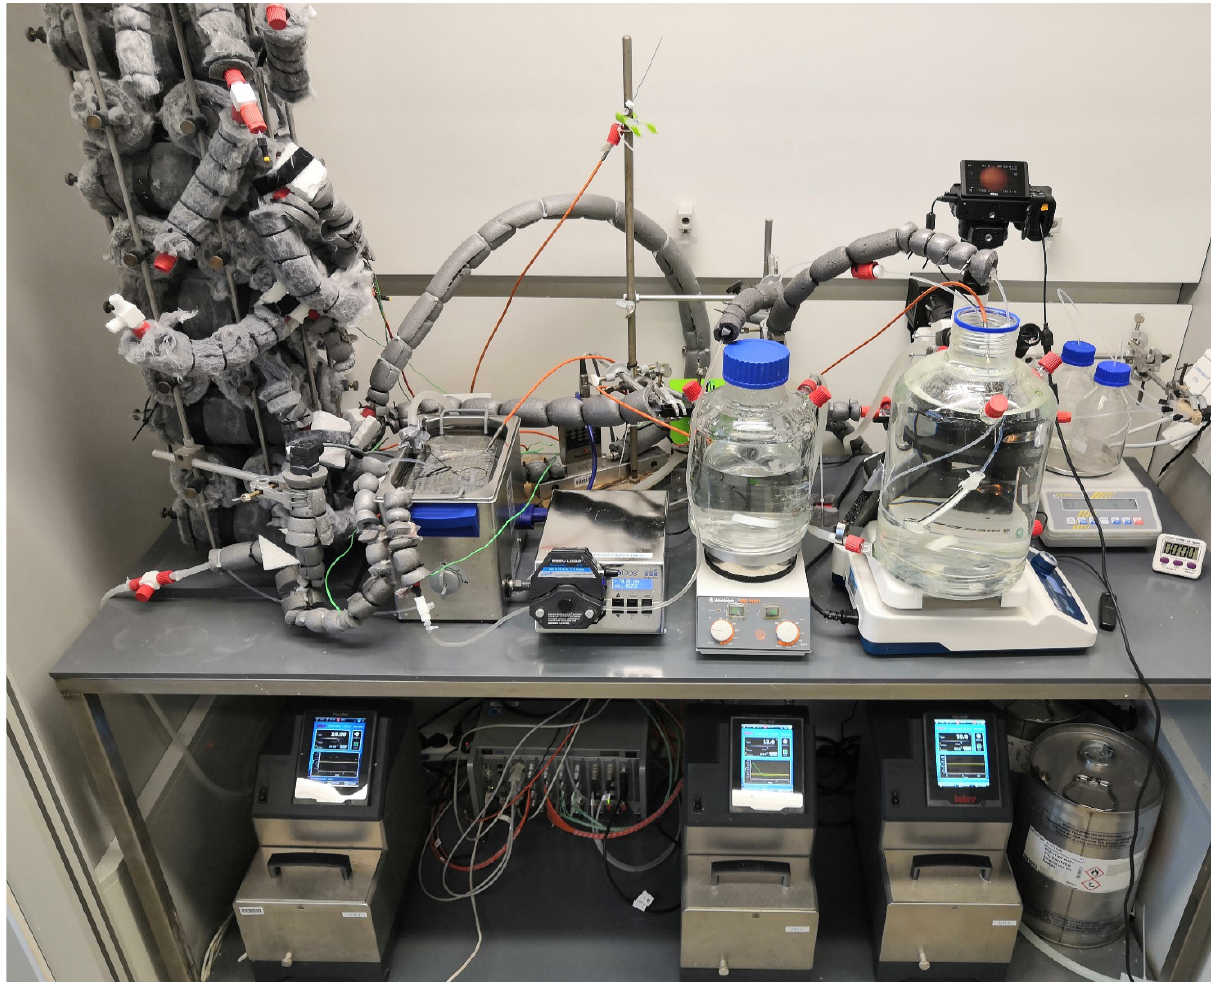
Figure A1. Solubility curve for glycine.